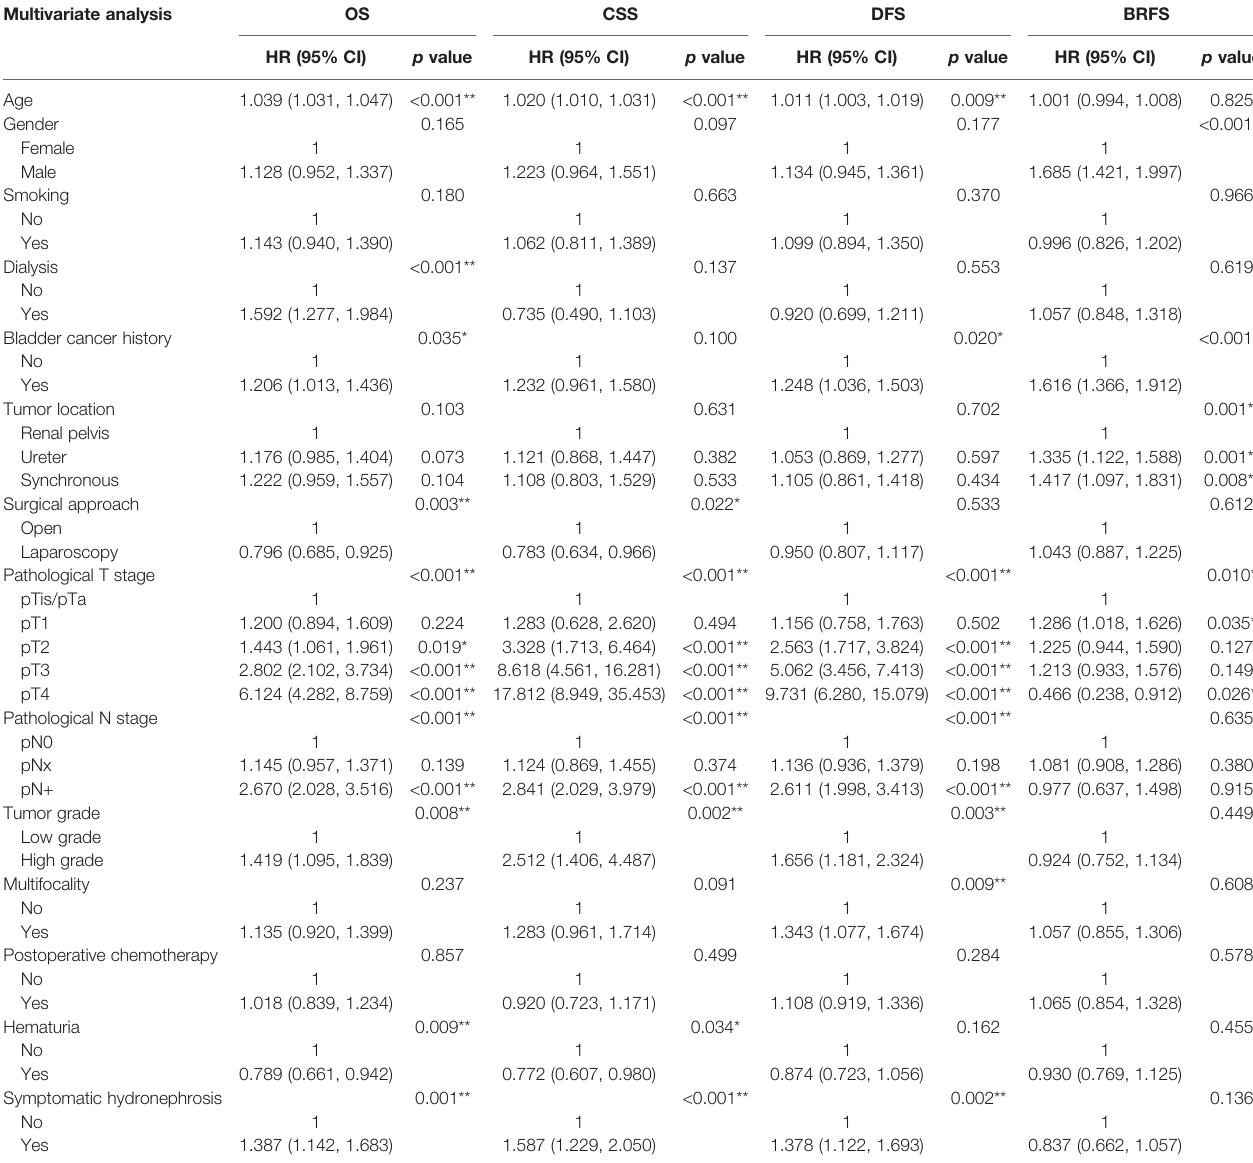
TABLE 4 | Comparative multivariate survival analysis of UTUC patients. Multivariate